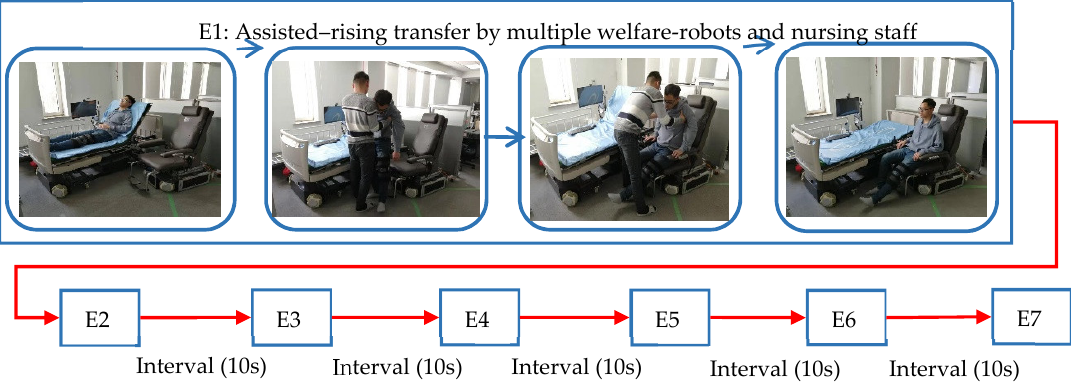
Figure 5. Experiments conducted: a total of 7 group experiments were performed by subjects with 10 s intervals.